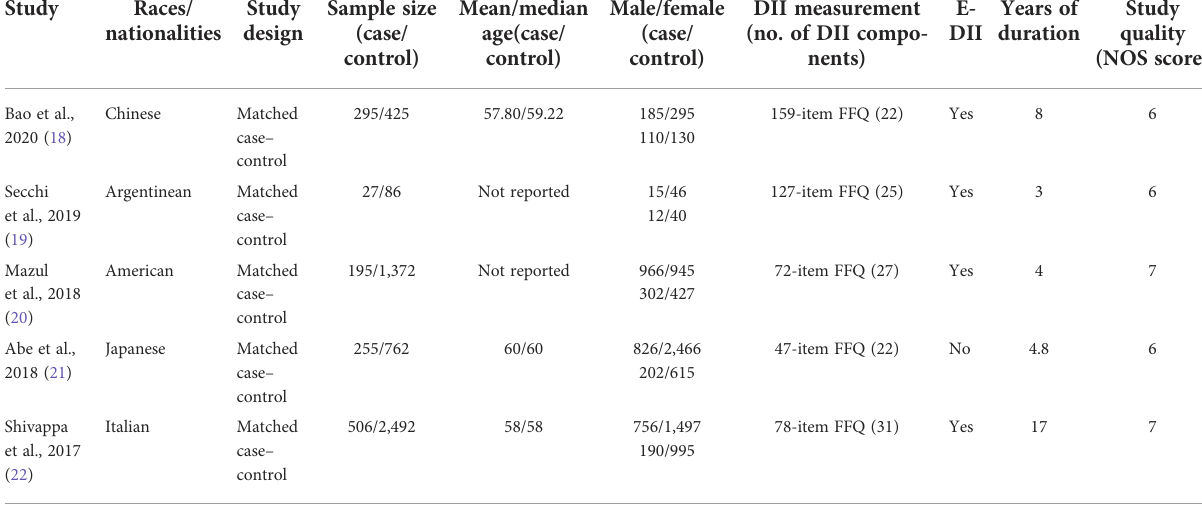
TABLE 1 General characteristics of included studies in the meta-analysis of DII and oral cancer